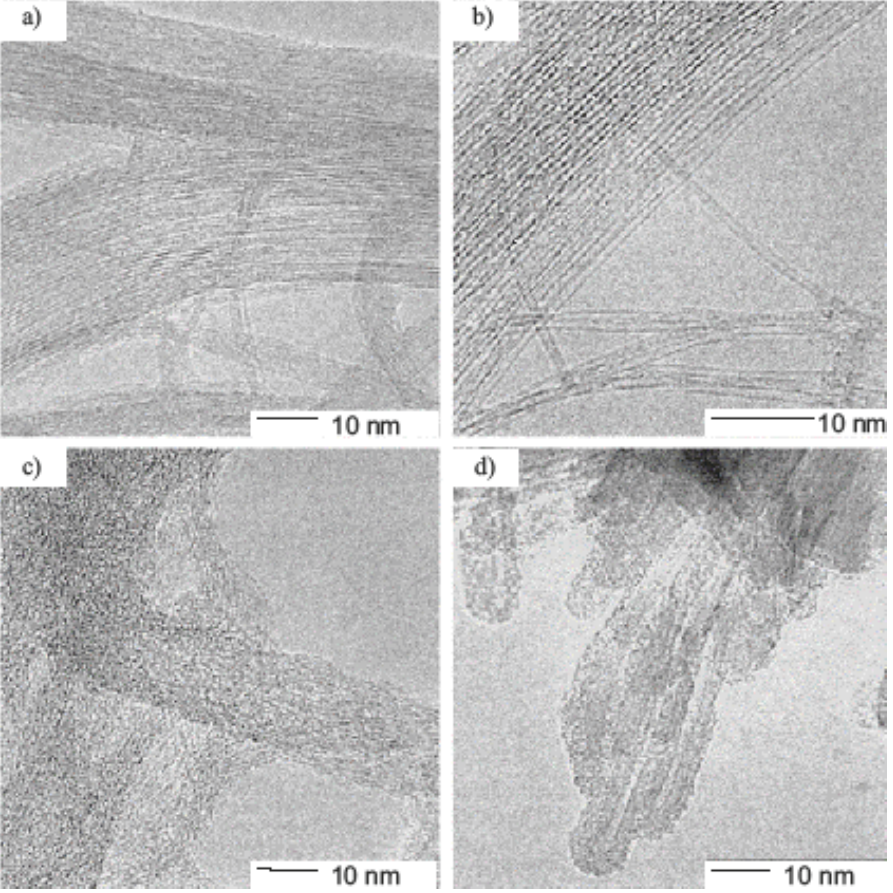
Figure 1. TEM micrograph of purified SWCNTs ( a ). TEM micrograph of SWCNTs after fluorination at 325 °C ( b ). TEM micrographs of SWCNTs after fluorination at 500 °C reveal a mixture of defective bundles ( c ) and MWCNTs ( d ). Scale bar, 10 nm. Reprinted with permission from Ref. [44]. Copyright 1998 Elsevier.